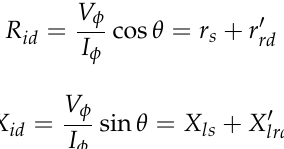
Figure 10. Locked rotor test experimental set-up.